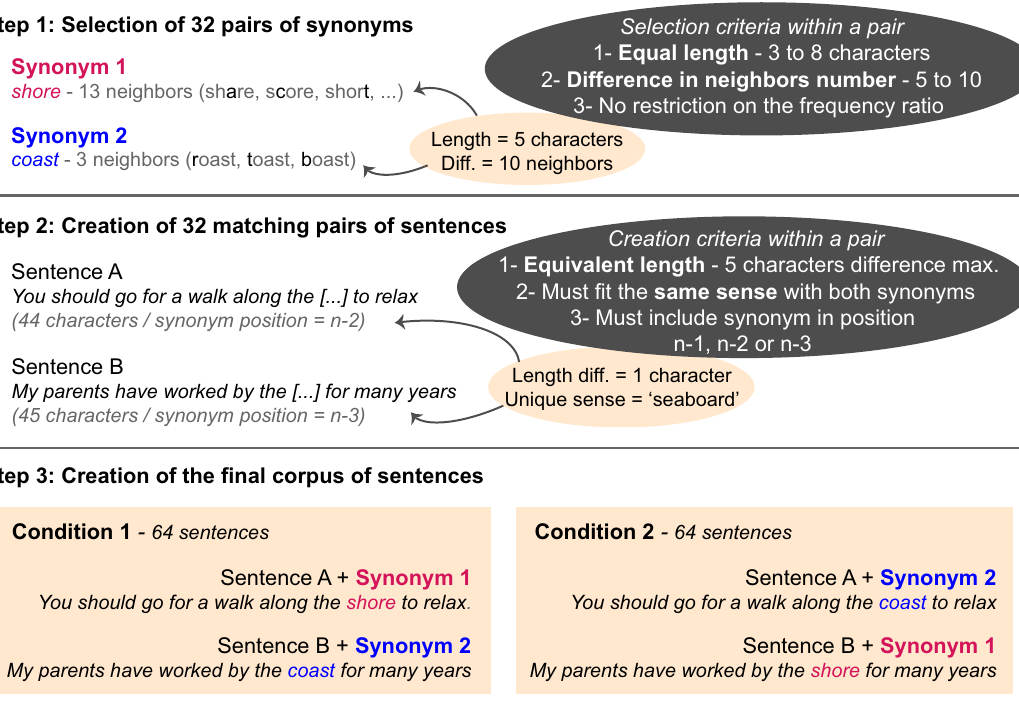
Figure 2. Creation of the reading material. Illustration of the reading material creation, using the synonym pair “ shore/coast ”. Both words in this example contain 5 characters. Their difference in number of neighbors is 10. Sentences A and B were created so either word of this synonym pair can fit in both sentences. In Condition 1, sentence A contains the target word 1 (‘shore’) and sentence B contains the target word 2 (‘coast’). In Condition 2, the pairing is reversed. Note that this example is given in English to ease understanding. See Supplementary Material for the complete set of French sentences